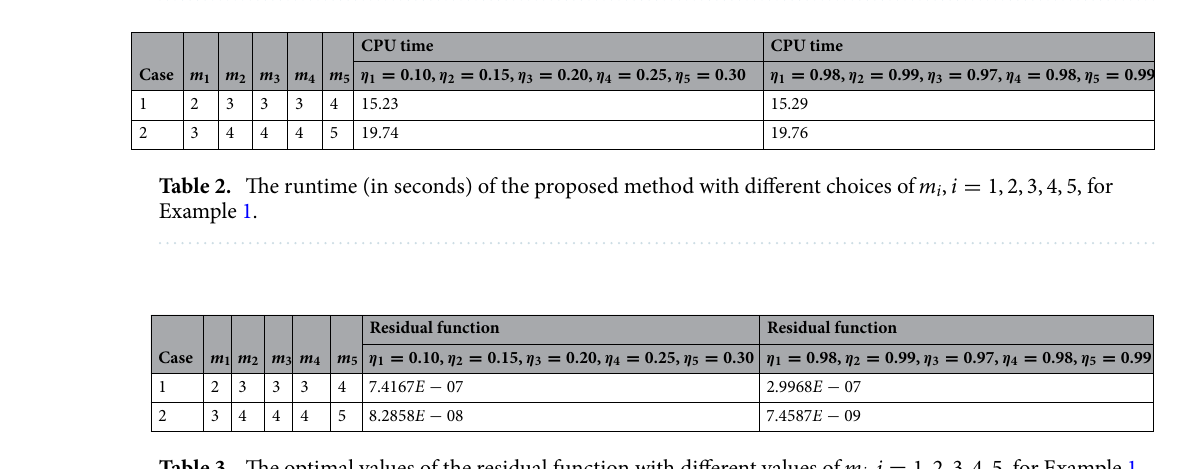
Table 3. The optimal values of the residual function with different values of m i , i = 1, 2, 3, 4, 5 , for Example